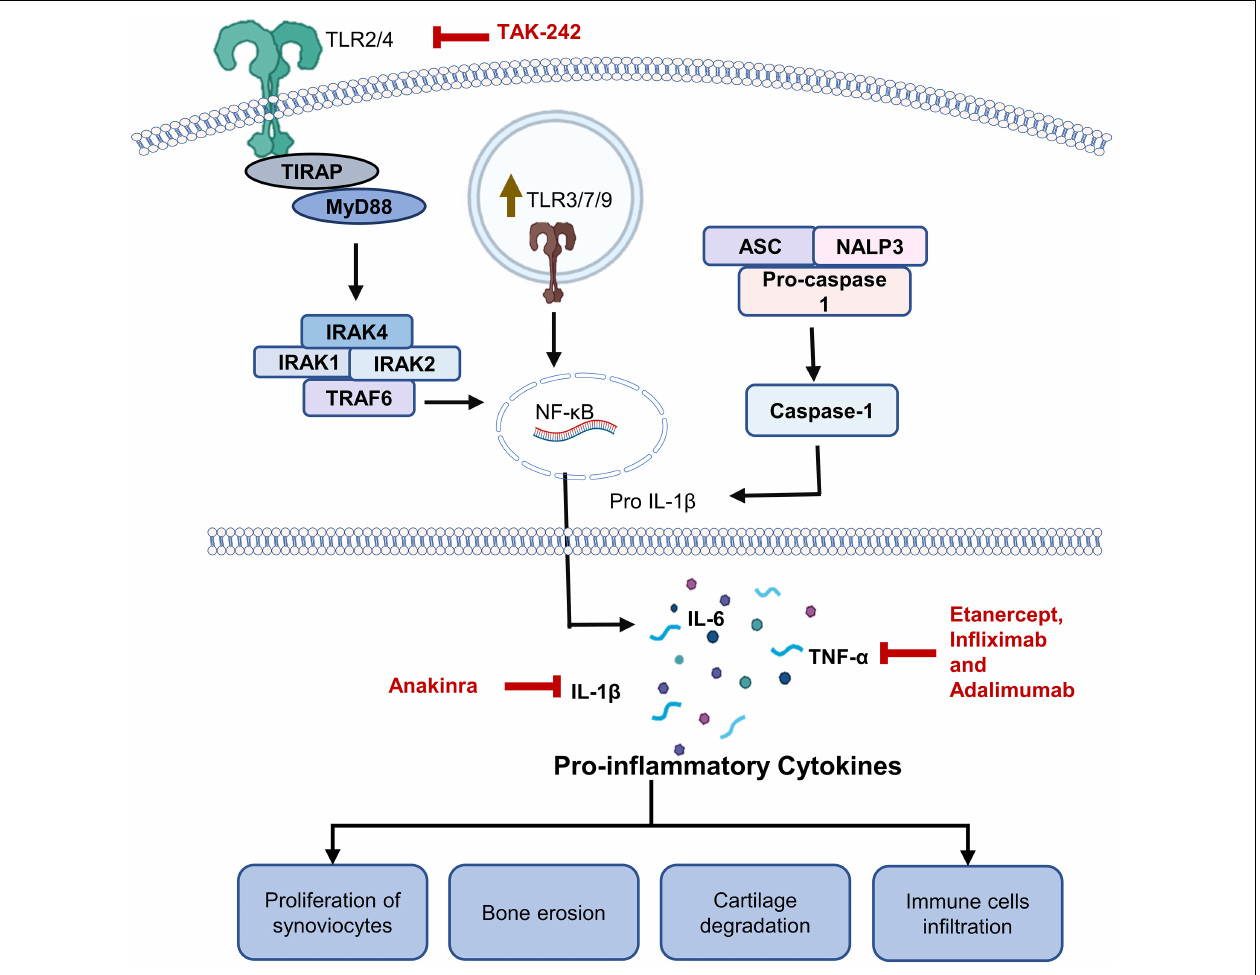
FIGURE 3 | Roles of TLRs in rheumatoid arthritis (RA). Role of TLR2/4 has been extensively studied in RA. Engagement of a TLR by a DAMP promotes release of certain cytokines through MyD88 dependent pathway. Level of TNF- α , IL-6, and IL-1 β have been found to be upregulated in RA patients. Upregulated cytokines lead to infiltration of immune cells, proliferation of synoviocytes ultimately leading to bone damage and cartilage degradation. Multiple monoclonal antibodies against TNF- α including etanercept, infliximab and adalimumab are commonly used for RA management. Patients who do not respond to anti-TNF- α antibodies are treated with anti–IL-1 β antibodies. TAK-242, which is a TLR4 inhibitor, is also being tested against